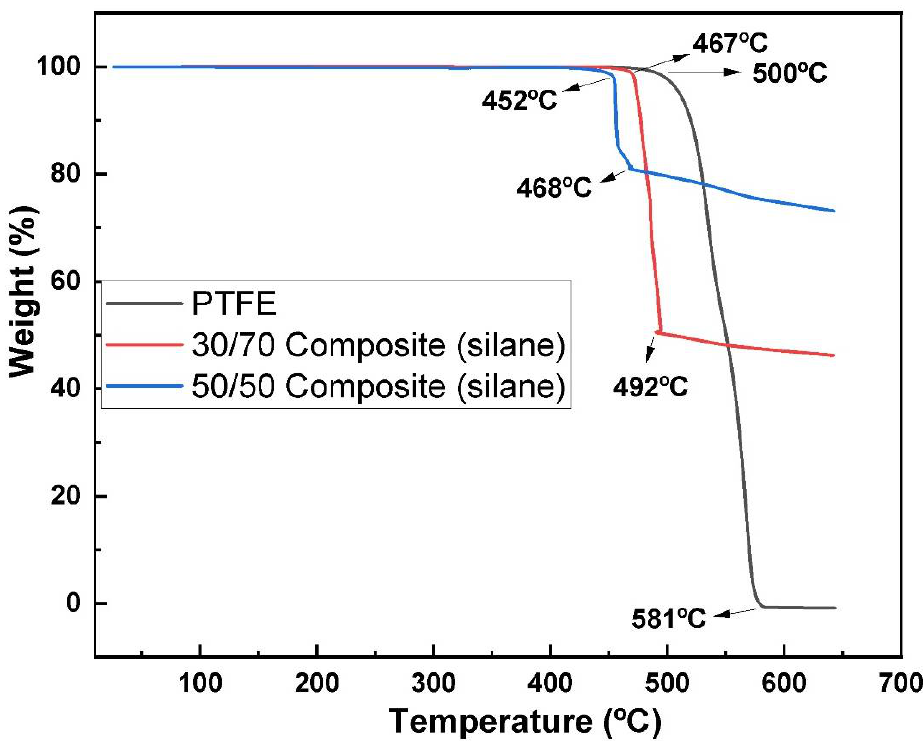
Figure 5. Thermogravimetric analysis (TGA) of 50/50 composite (silane), PTFE, and 30/70 composite (silane).